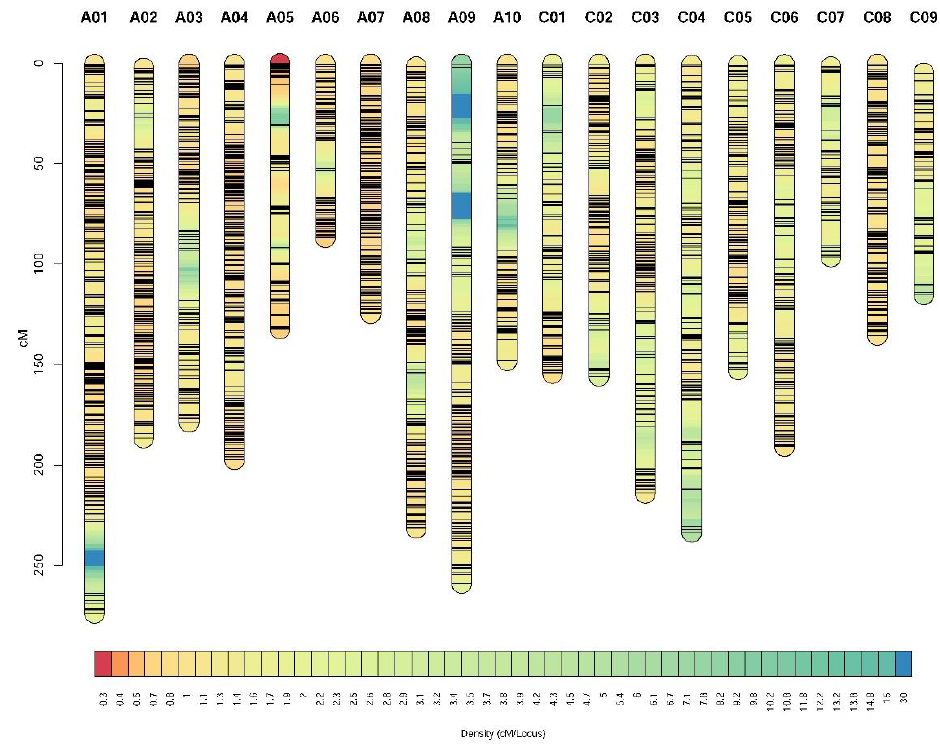
Figure 3. Genetic linkage map of the 158A-SGDH population. The name of each linkage group is shown above it. The ruler on the left indicates the genetic position in centimorgans (cM). The color scale at the bottom represents the density of markers (cM/locus).